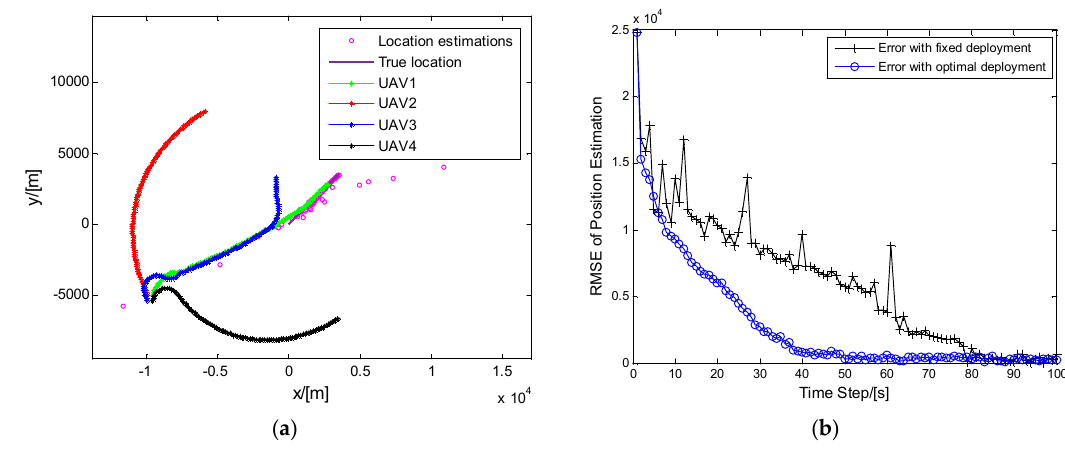
Figure 7. ( a ) Optimal paths for dynamic emitter location and tracking. ( b ) Comparison of localization performance: optimal deployment and fixed deployment.